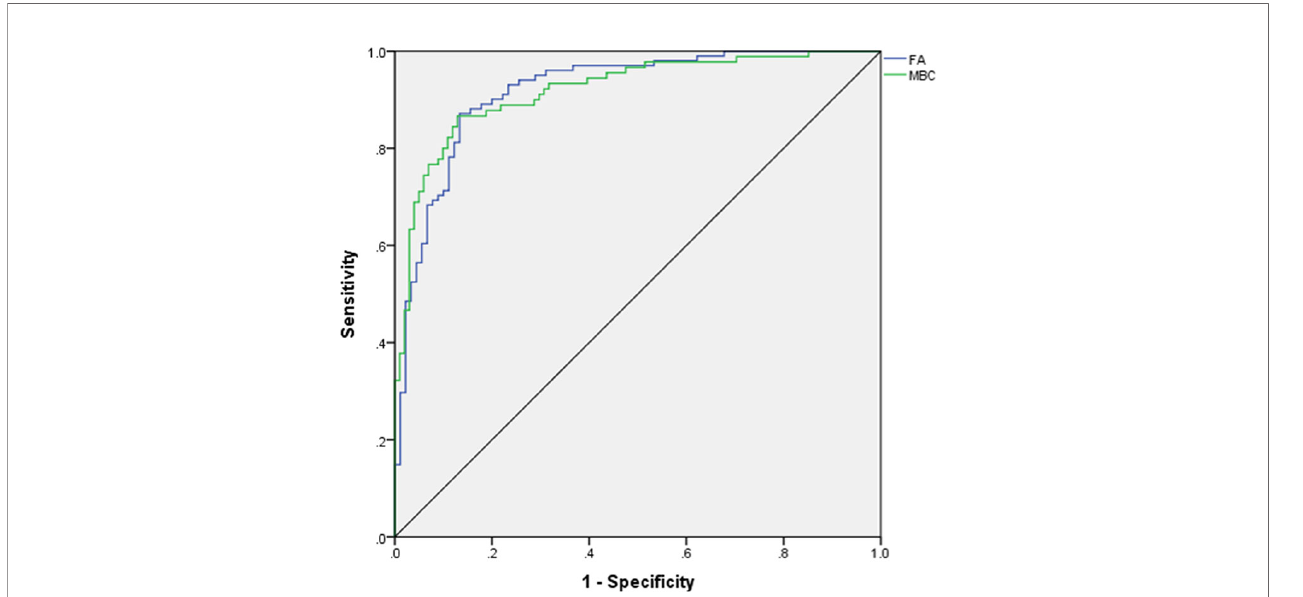
FIGURE 1 | ROC for differentiating mucinous breast carcinoma from fi broadenoma. ROC, receiver operating characteristic curve; AUC, area under curve; FA, fi broadenoma; MBC, mucinous breast carcinoma.